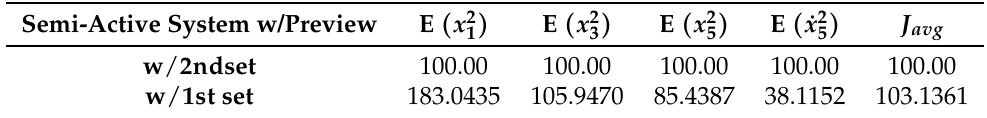
Figure 7. ( a – d ) Time responses of semi-active system with 0.1 second preview time to bump input using (i) 1st weighting sets: – – – – ; (ii) 2nd weighting sets: ——– . Table 3. Components of performance indices obtained by semi-active suspension system with 0.1 s preview after running on asphalt